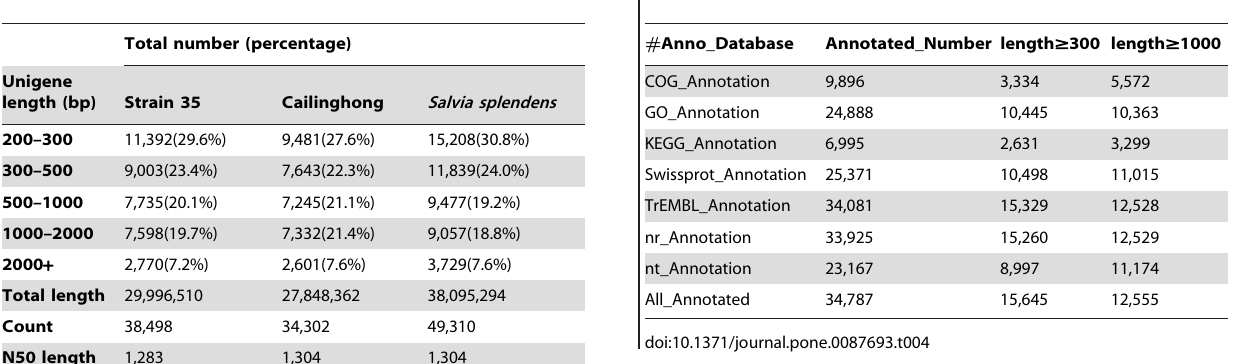
Table 3. Summary of unigenes for Sal via splendens .